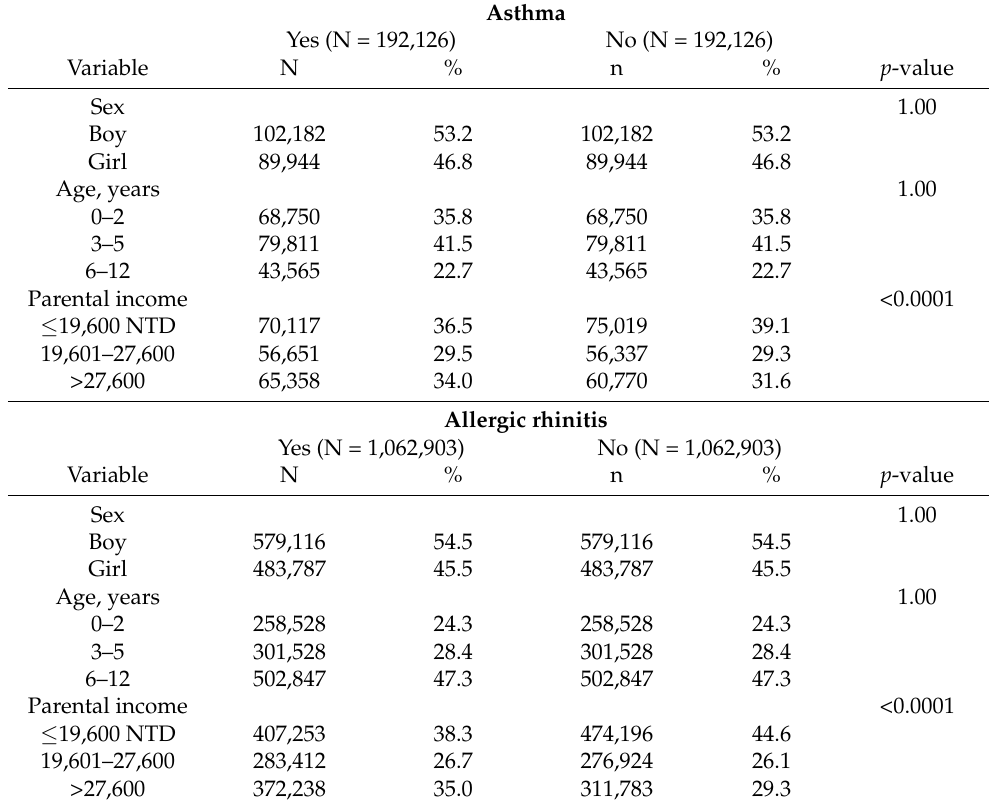
Table 1. Comparison between cohorts with and without asthma and between cohorts with and without allergic rhinitis by demographic factors.